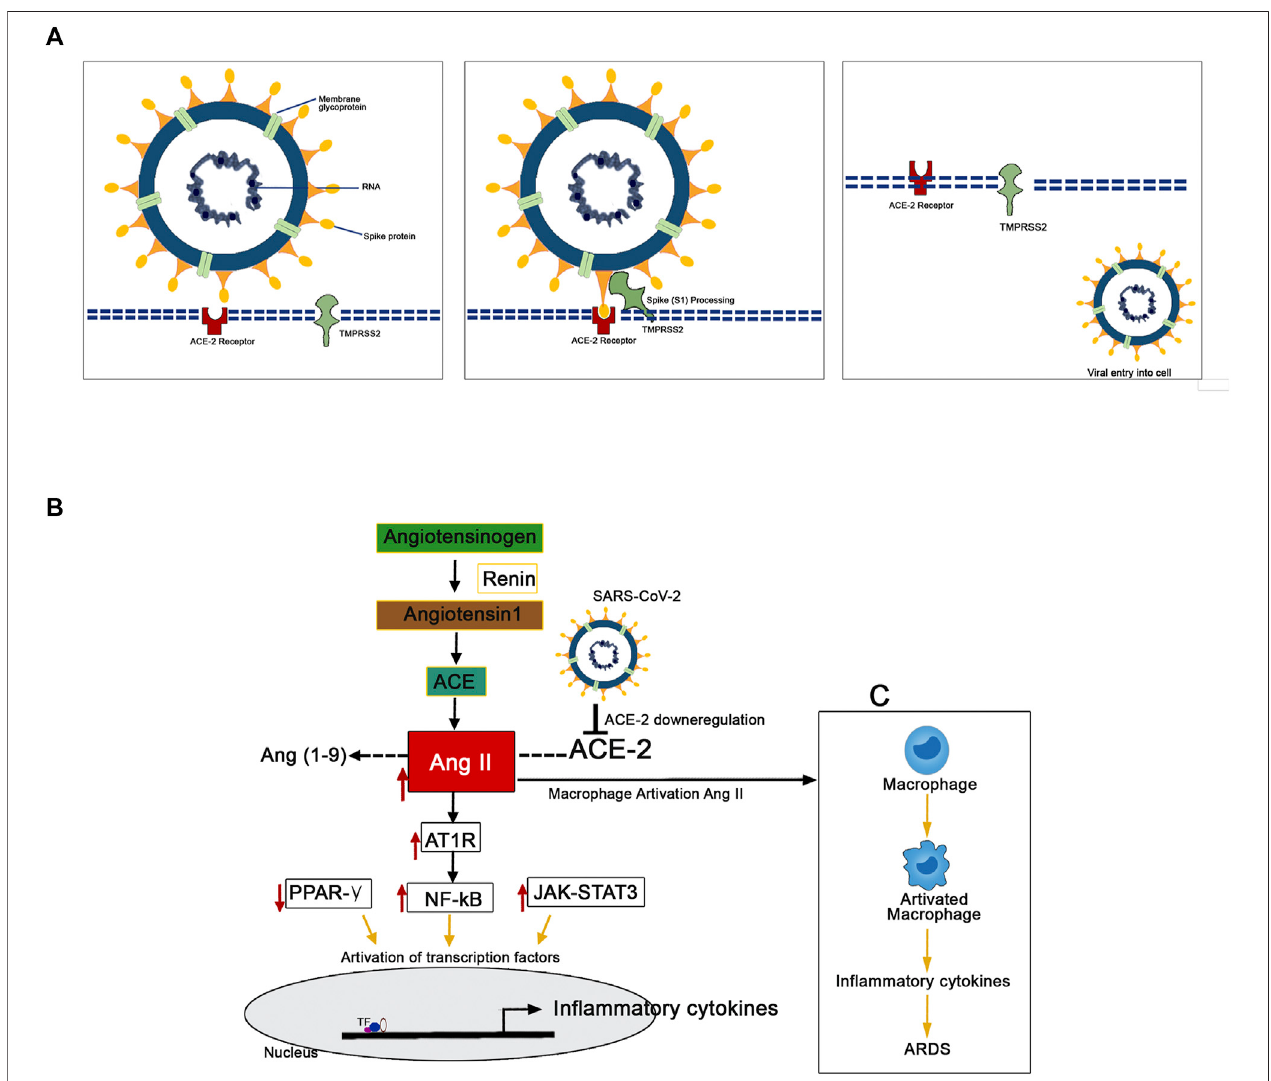
FIGURE 3 | Mechanism of the pathogenesis of SARS-CoV-2 infection. (A) The TMPRSS2 process spike proteins for the binding with ACE-2 receptors present in the human epithelial cell membrane. (B) SARS-CoV-2 downregulates the expression ofACE-2 resulted in the upregulated expression patternof Ang II. This Ang II binds with plasma membrane receptor AT1R and transduces signals to activate in fl ammatory transcription factors like NF-kB, STAT-3. These activated transcription factors are involved in the overexpression of several in fl ammatory. (C) The Ang II/AT1R interaction activates macrophages to produce excessive in fl ammatory cytokines that resulted in a “ cytokine storm.